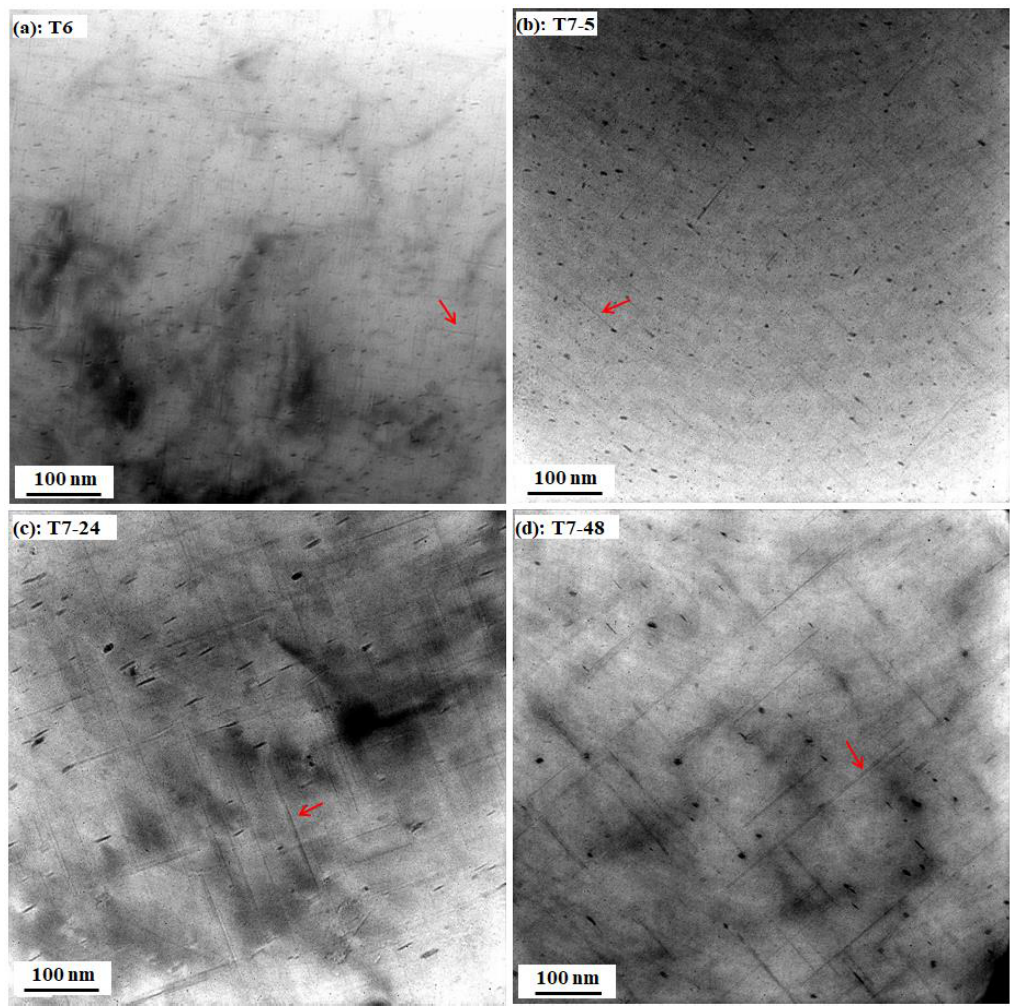
Figure 4. Transmission electron microscopy (TEM) bright-field images of the precipitates under various aging conditions. ( a )T6; ( b )T7-5; ( c ) T7-24; and ( d )T7-48.